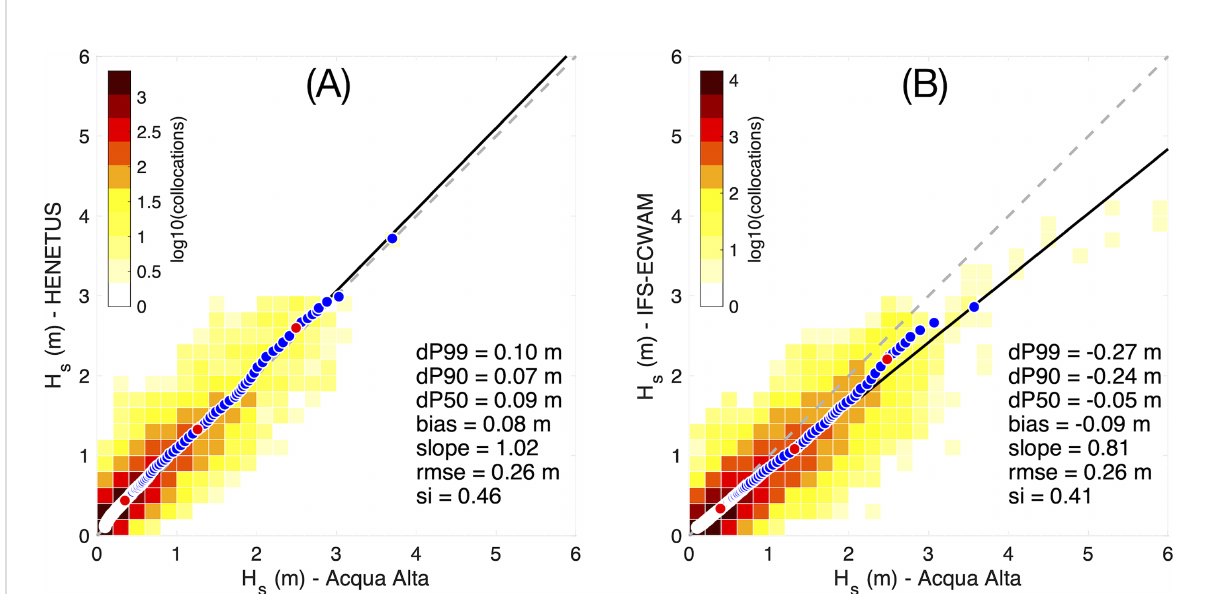
FIGURE 8 Performance of HENETUS (A) and IFS-ECMWF (B) in all conditions ( H s ≥ 0.1m) at “ Acqua Alta ” tower station, for comparison with PELMO (Figure 7A). Black line is the linear regression line of the data (reference 1:1 line is gray colored and dashed). Blue dots represent the percentiles of the quantile-quantile plot, from 1 st to 99.9 th ; red dots represent the 50 th , 90 th and 99 th percentile (from left to right), respectively.